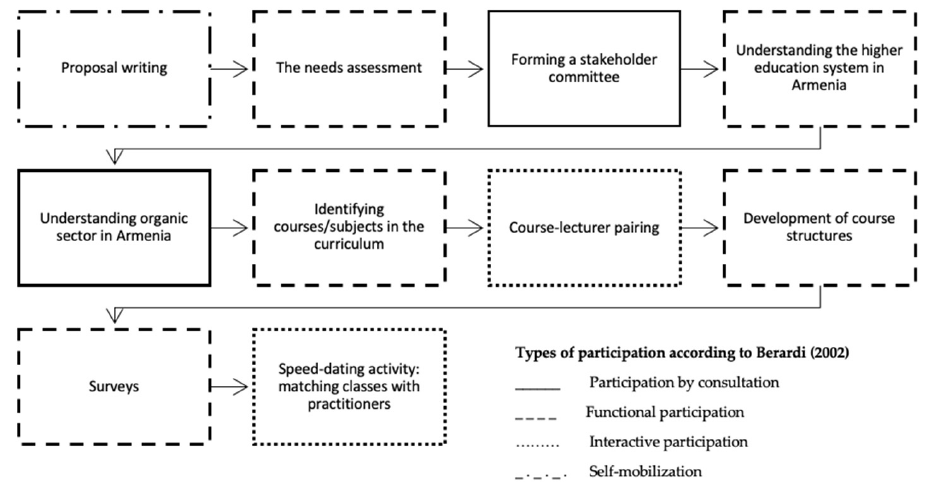
Figure 2. Conceptual mapping of participatory curriculum development of the Organic Agriculture Master’s program and types of participation.